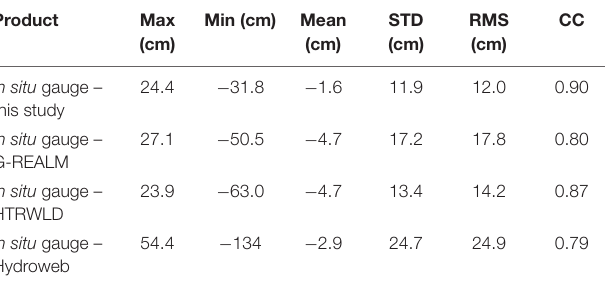
TABLE 3 | Comparative statistics of lake level in Zhari Namco from different databases. Product